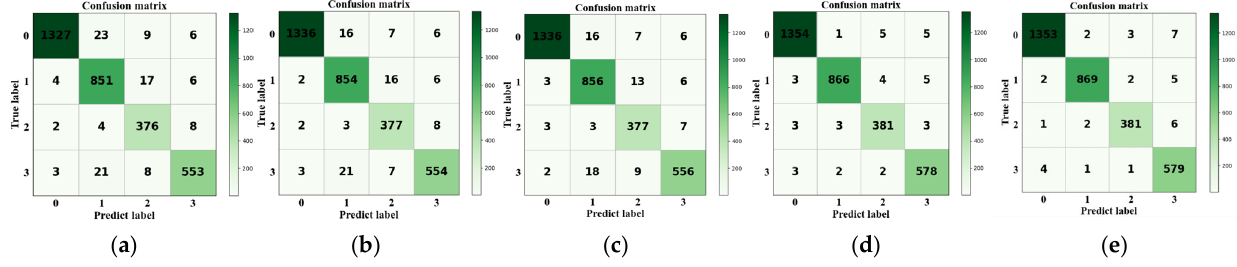
Figure 10. Confusion matrices for ( a ) 1D-CNN, ( b ) 2D-CNN, ( c ) ResNet, ( d ) 2D-CNN+CBAM, and ( e ) ResNet+CBAM.